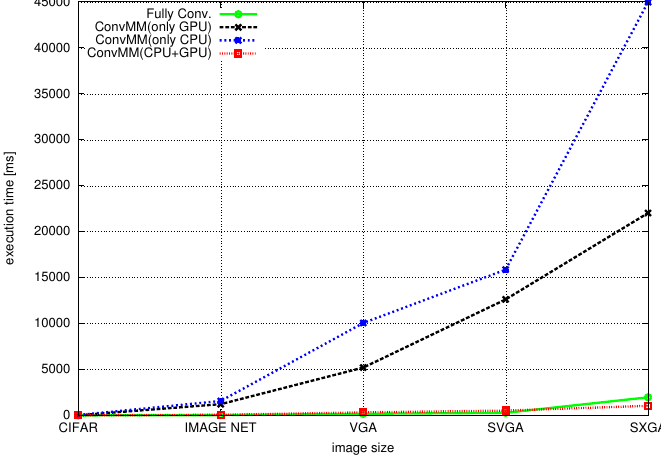
Figure 7. Comparison of different approaches to convolution operations as a function of the input image